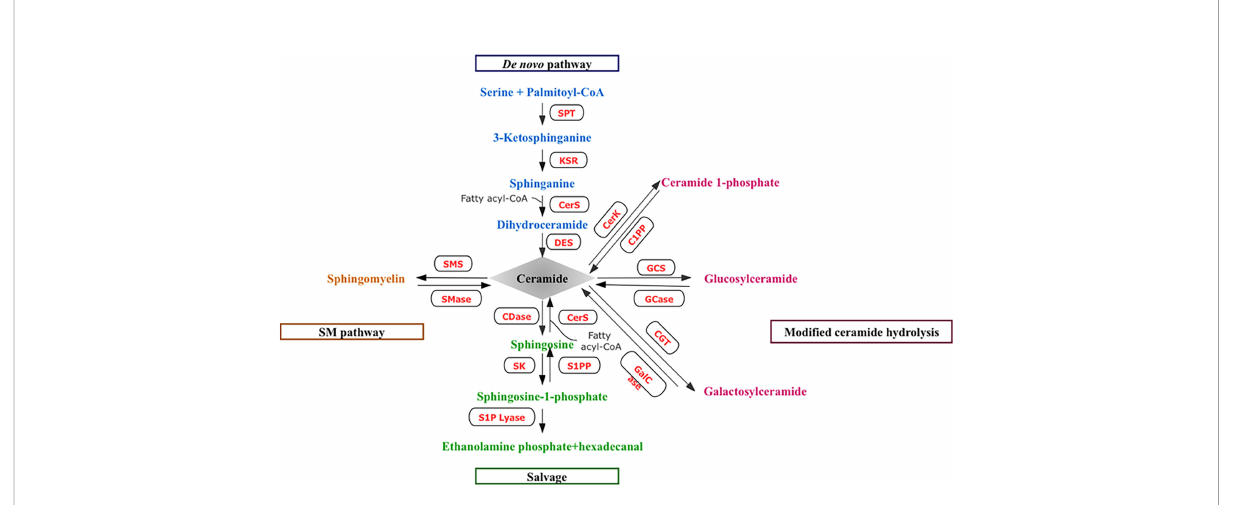
FIGURE 1 Metabolic pathway of